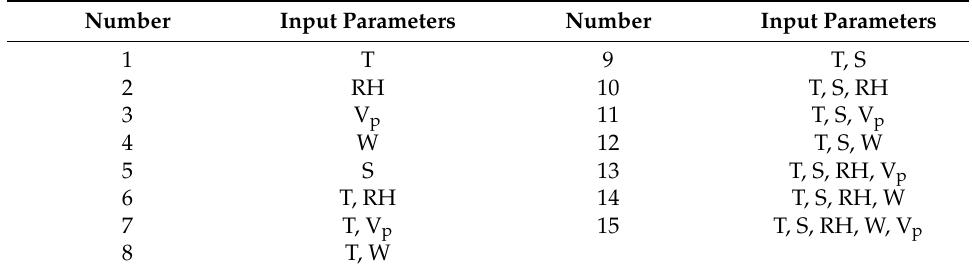
Table 3. Different combinations of input parameters in the estimation of dew point temperature.